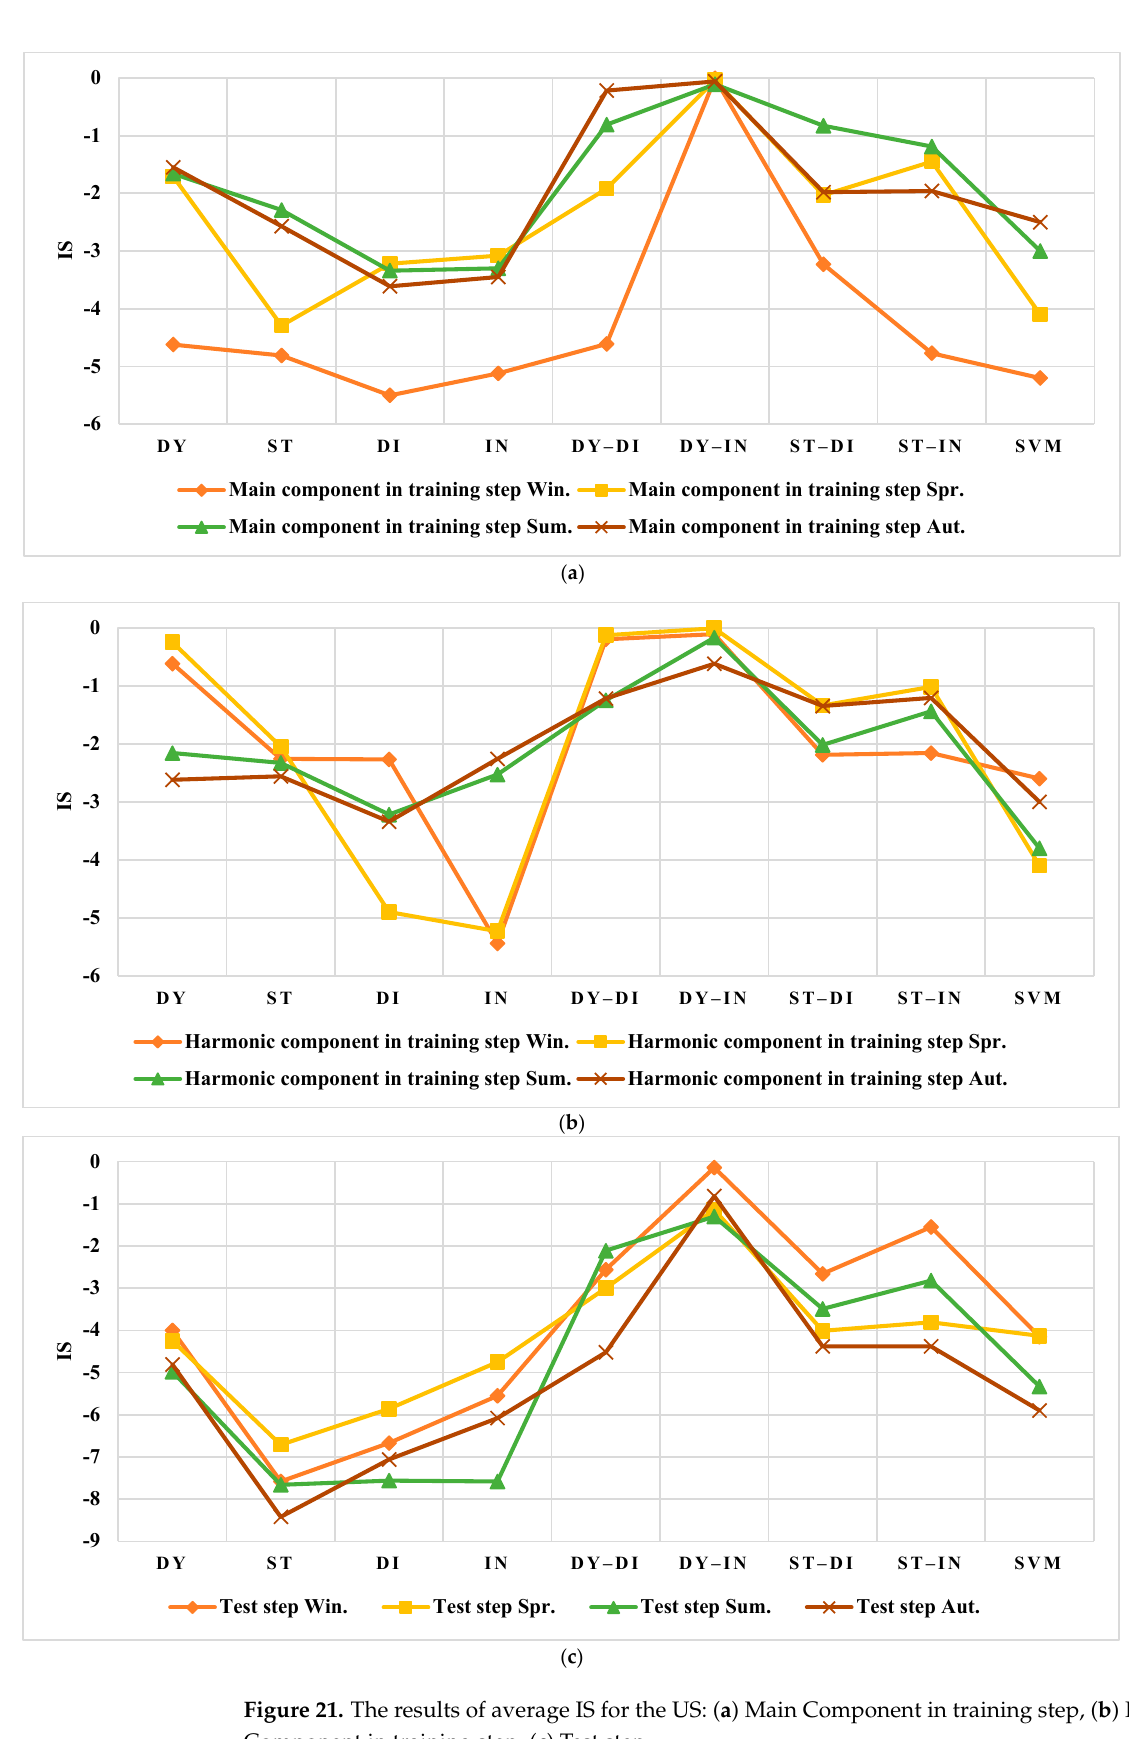
Figure 20. The results of PINAW (%) for the US: ( a ) Main Component in training step, ( b ) Har- monic Component in training step, ( c ) Test step The values of IS by the dynamic indirect GP are closer to zero in comparison to the other methods, especially in the test step results of the static GP, indirect GP, and direct GP. Therefore, based on the information in Figure 21, the best manner is the dynamic indirect GP.